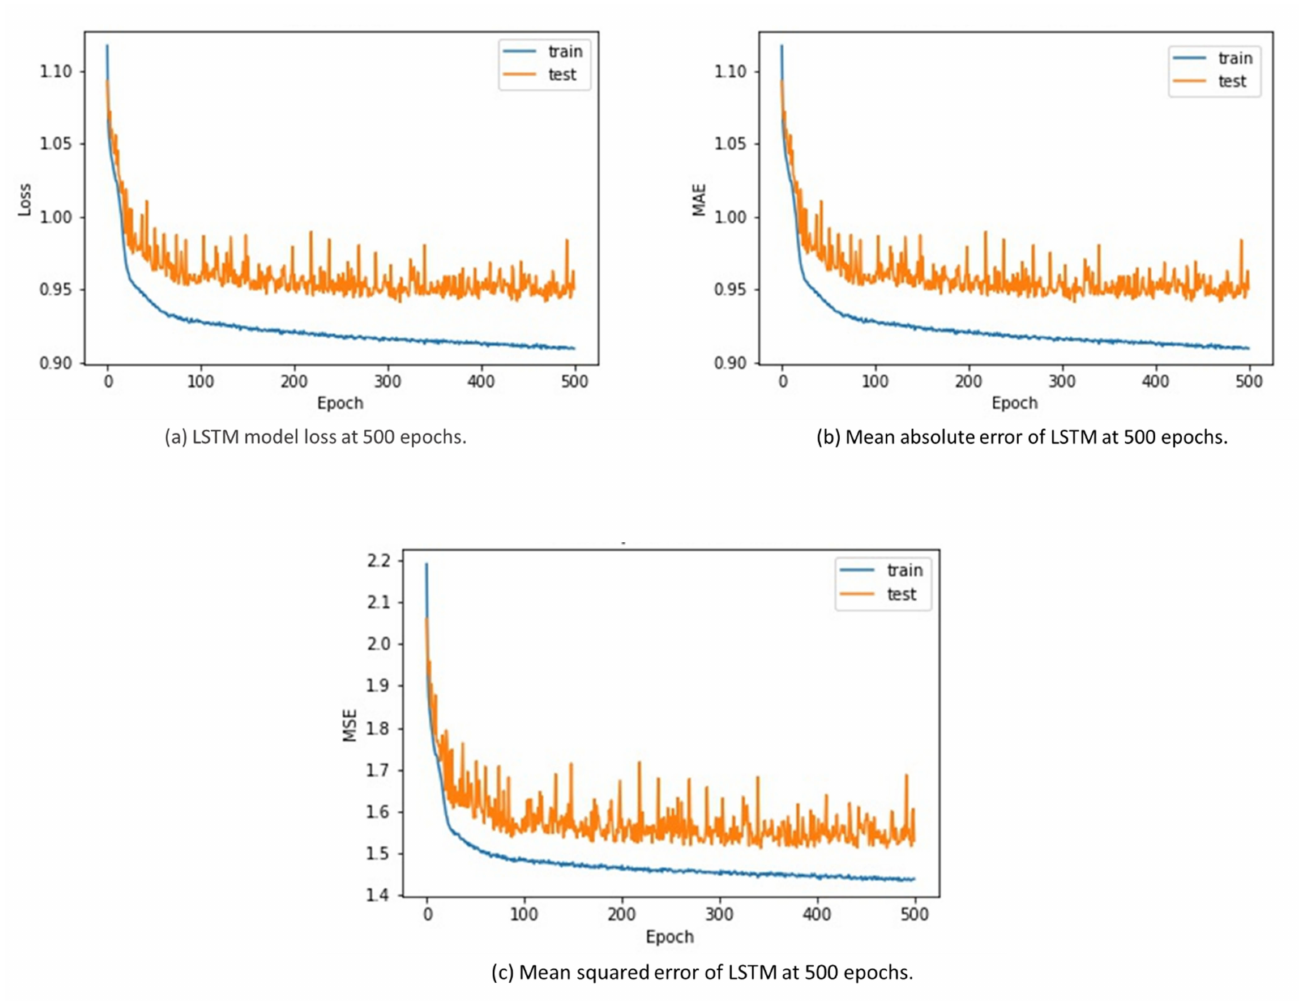
Figure 6. Statistical error measures of the LSTM per